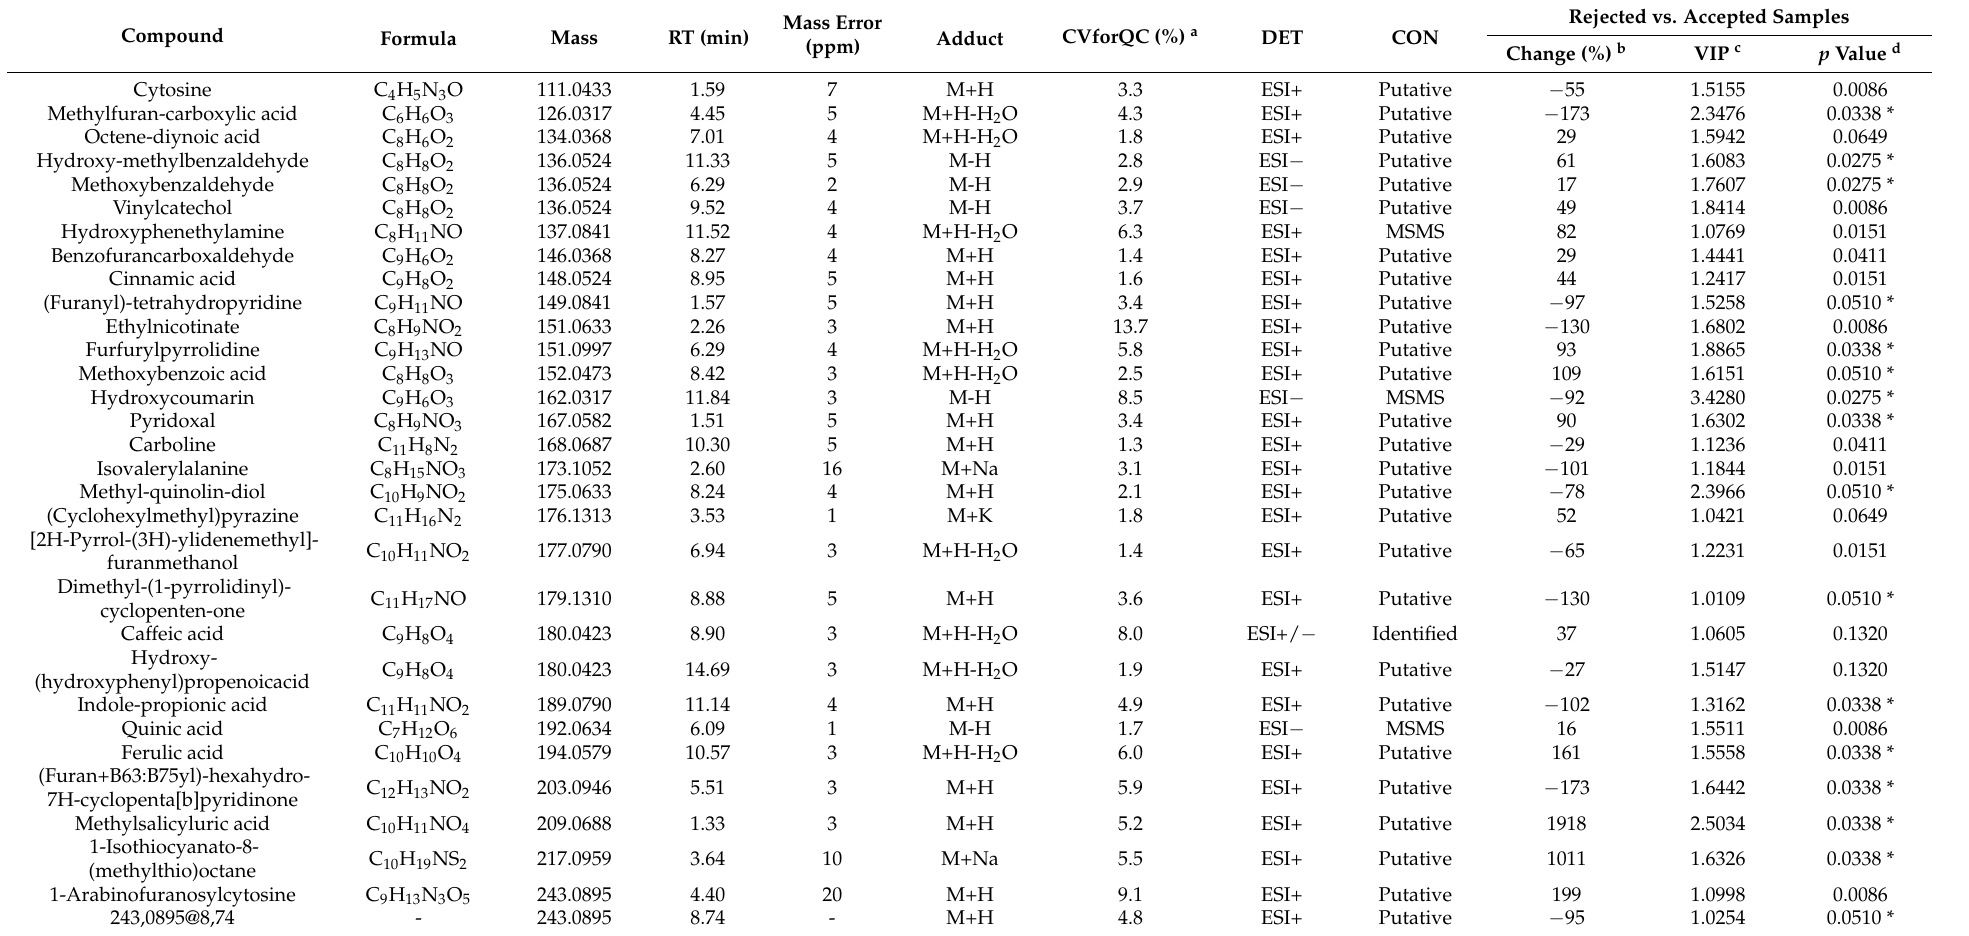
Table 1. Metabolites significantly differentiated between the Accepted and Rejected groups using both ESI modes by untargeted metabolomics via quadrupole time-of-flight mass spectrometry